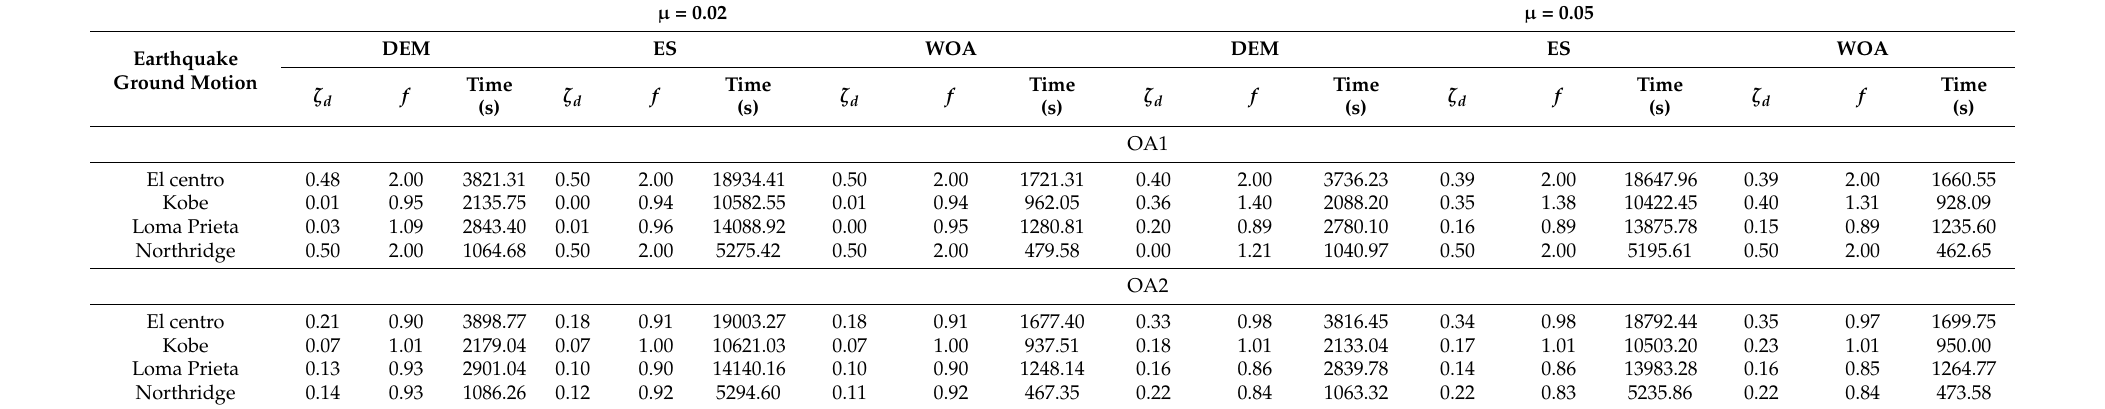
Table 3. TMD design parameters optimized by objective function OA1 and OA2. µ = 0.02 µ =